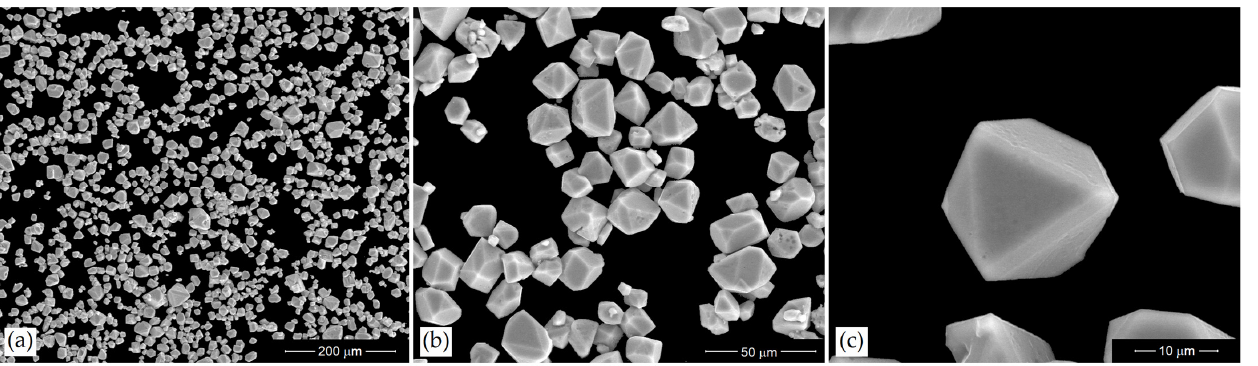
Figure 1. SEM images of the Fe 3 O 4 dispersed powder, including ( a ) 400 × magnification, ( b ) 1600 × magnification, and ( c ) 6000× magnification with morphology details.